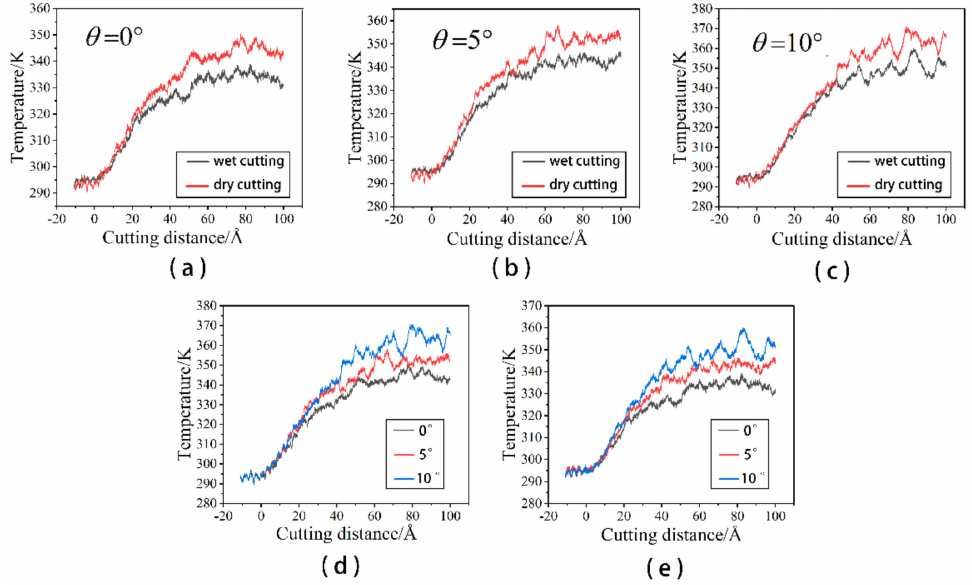
Figure 4. The temperature change of the workpiece. ( a ) θ = 0 ◦ ; ( b ) θ = 5 ◦ ; ( c ) θ = 10 ◦ ; ( d ) workpiece temperature change during dry cutting; and ( e ) workpiece temperature change during wet